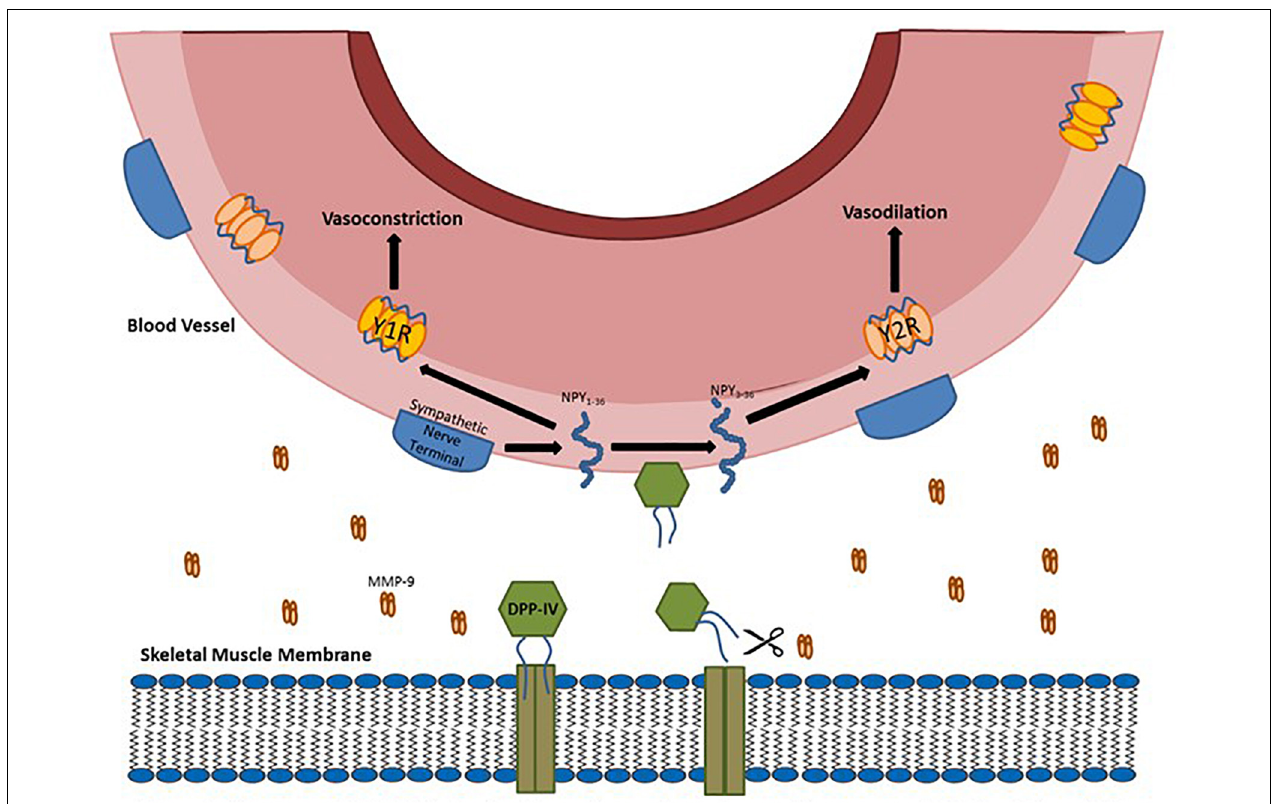
FIGURE 1 | Diagram of DPP-IV being shed from the membrane by metalloproteases (MMP) and the soluble DPP-IV cleaving full length NPY into